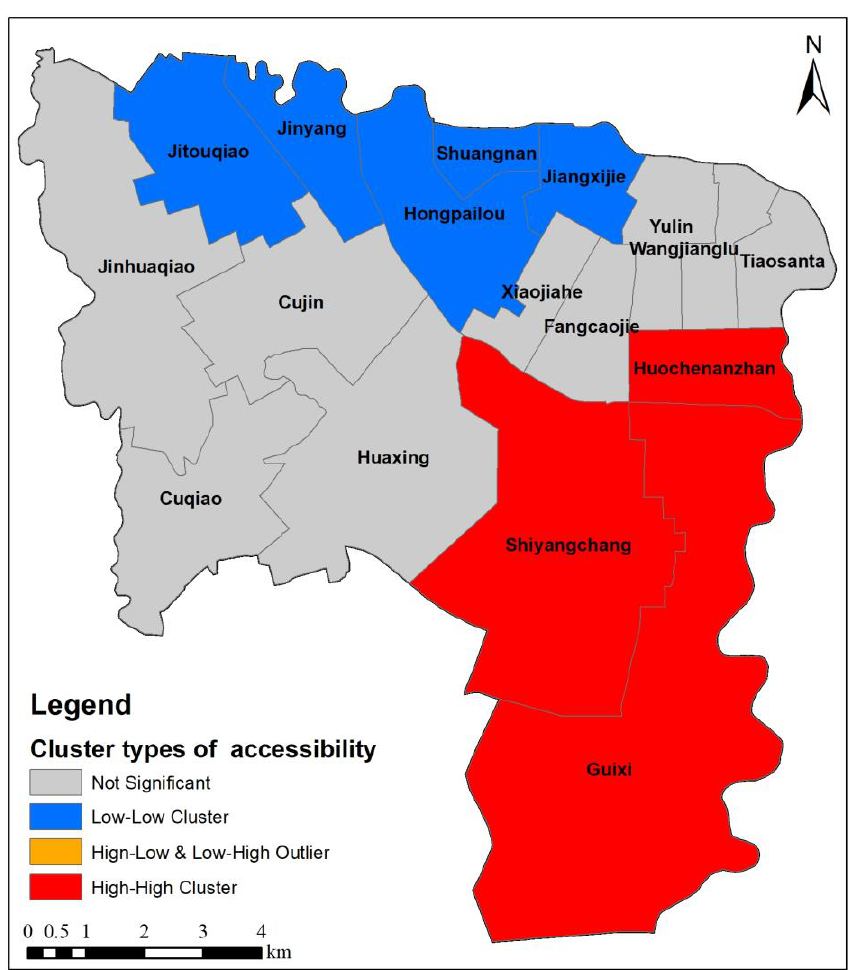
Figure 10. Cluster types of park spatial accessibility.